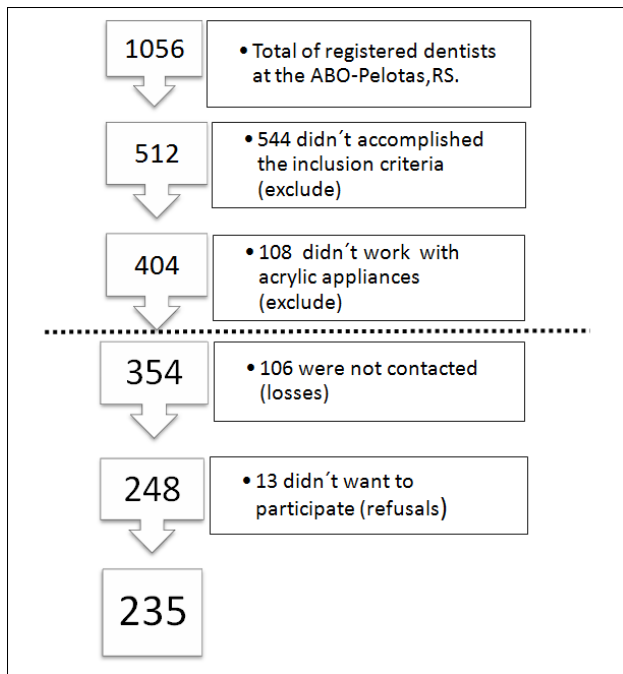
Fig.1. Flowchart of dentist’s selection for telephone survey, Pelotas, RS,